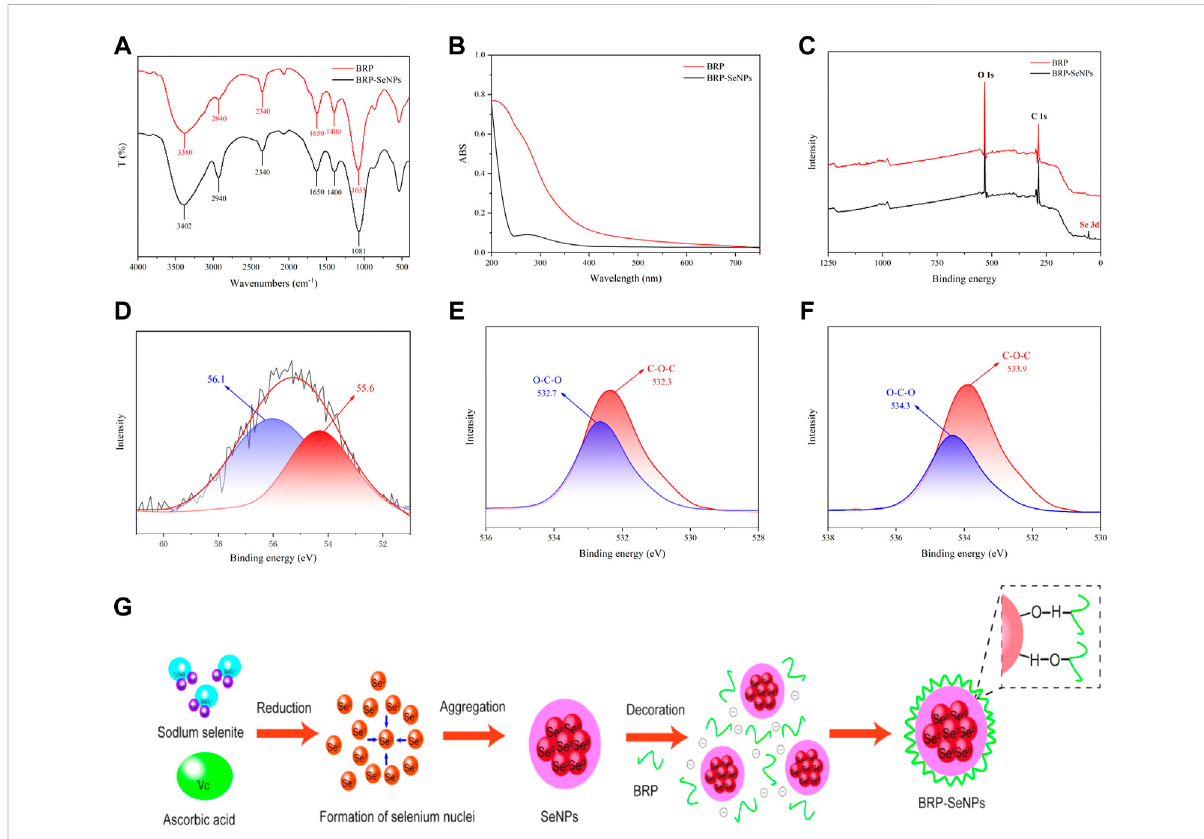
FIGURE 2 Characterization of BRP-SeNPs. (A) FT-IR spectrum. (B) UV-vis absorption spectrum. (C) XPS spectrum of BRP and BRP-SeNPs. (D) High- resolutionSe3 daysspectrumofBRP-SeNPs.O1sspectrumof (E) BRPand (F) BRP-SeNPs. (G) SchematicdiagramsofformationmechanismofBRP-